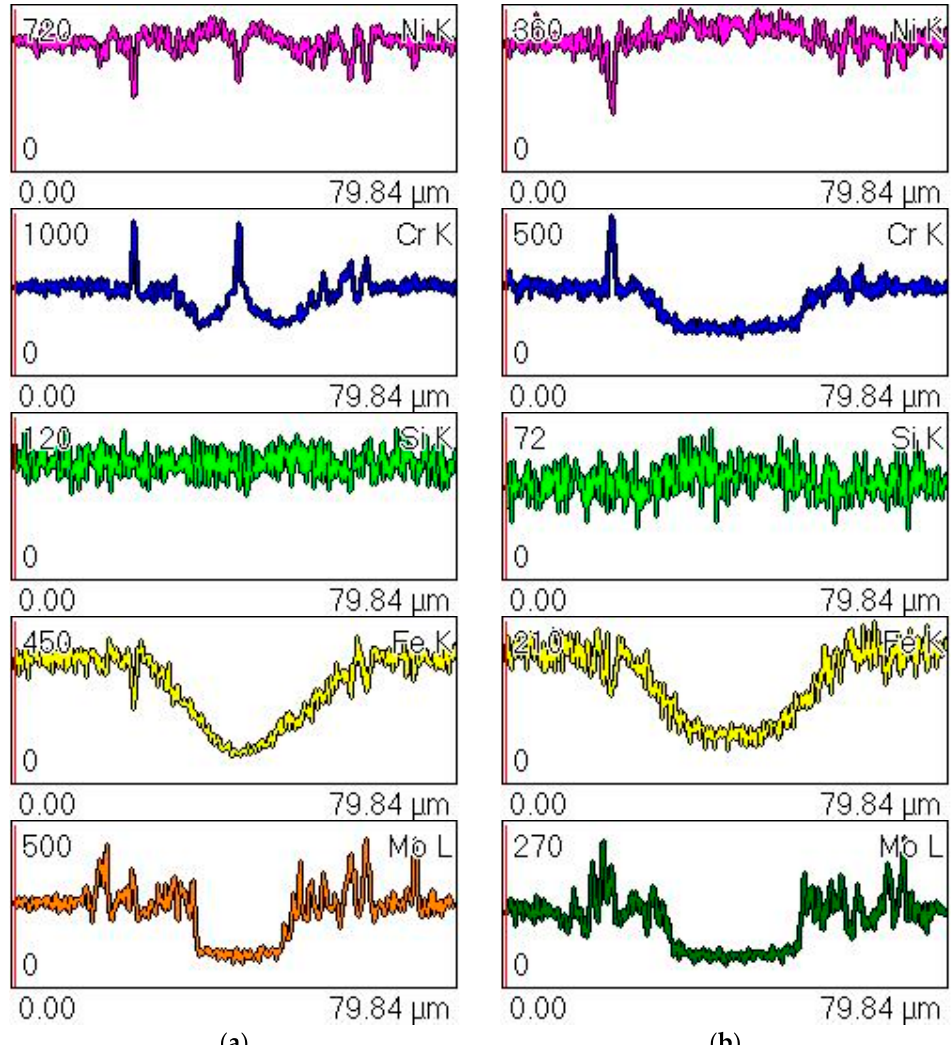
Figure 4. Structure of Hastelloy X–Ni-Pd-Cr-B-Si joint and linear distributions of element concentration along the marked line after 10 min ( a ) and after 30 min ( b ) brazing time at 995 °C.